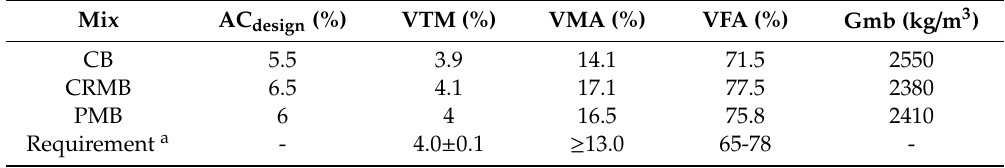
Table 5. Results of the mix design